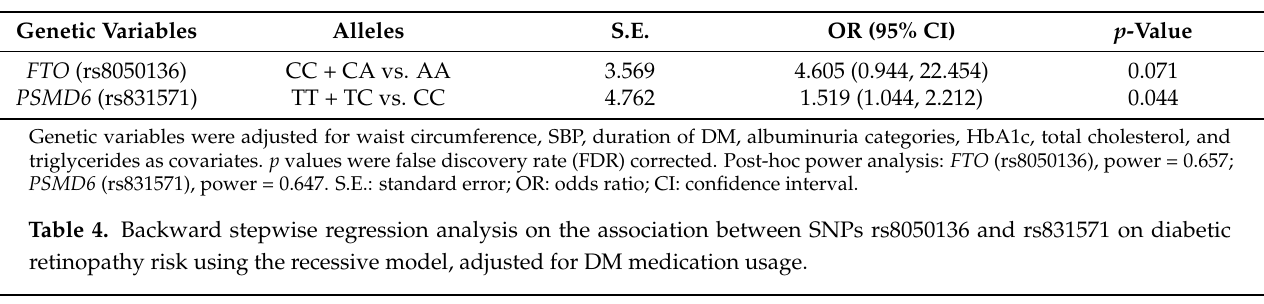
Table 3. Backward stepwise regression analysis on the association between SNPs and diabetic retinopathy using the recessive model.